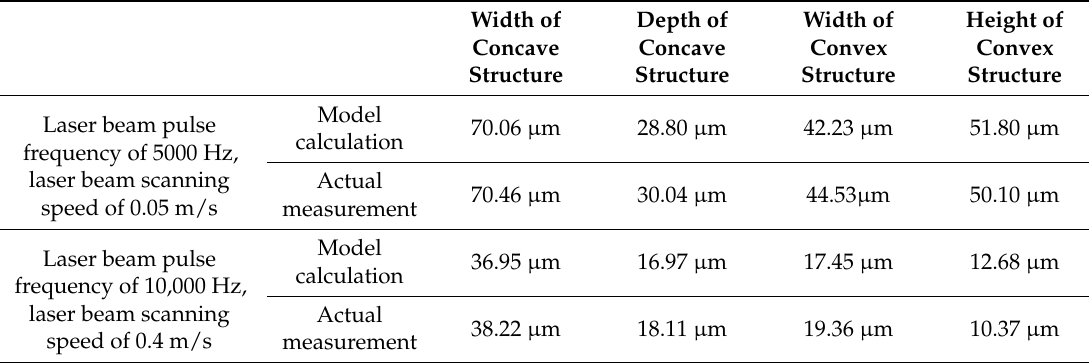
Figure 14. SEM images of the microstructure on Al alloy surface treated by laser micro-engraving: ( a ) laser beam pulse frequency of 5000 Hz, laser beam scanning speed of 0.05 m/s; ( b ) laser beam pulse frequency of 10,000 Hz, laser beam scanning speed of 0.4 m/s. Table 1. Dimensions of the microstructure.